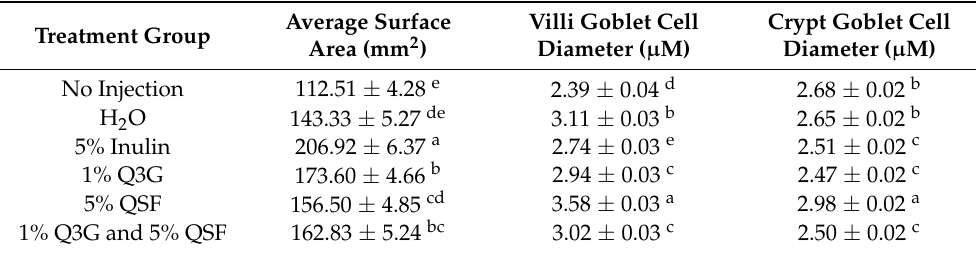
Table 4. Effect of intra-amniotic administration of treatments and controls on villi surface area and goblet cell diameter in duodenal villi and crypts.